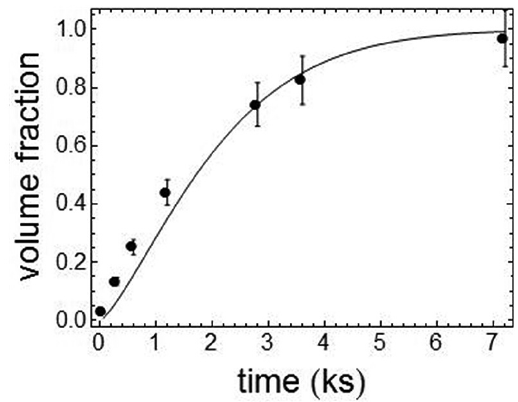
Figure 4. Comparison between model (solid line), Equation 6, and the total theoretical volume fraction (filled